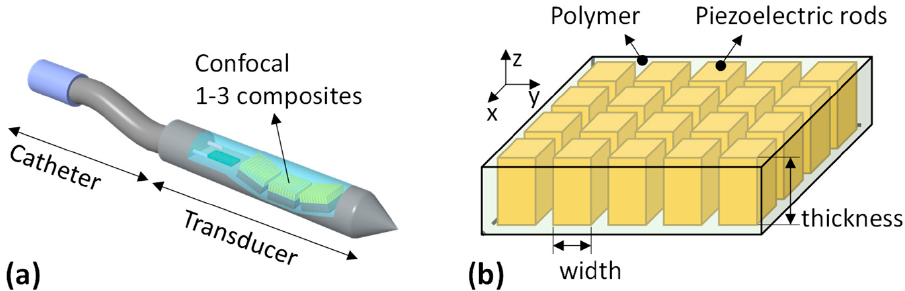
Figure 1. Schematic of the miniaturized, interstitial, focused ultrasound transducer, directed by the catheter ( a ), and the structure of 1–3 piezoelectric composite as an active layer ( b ).